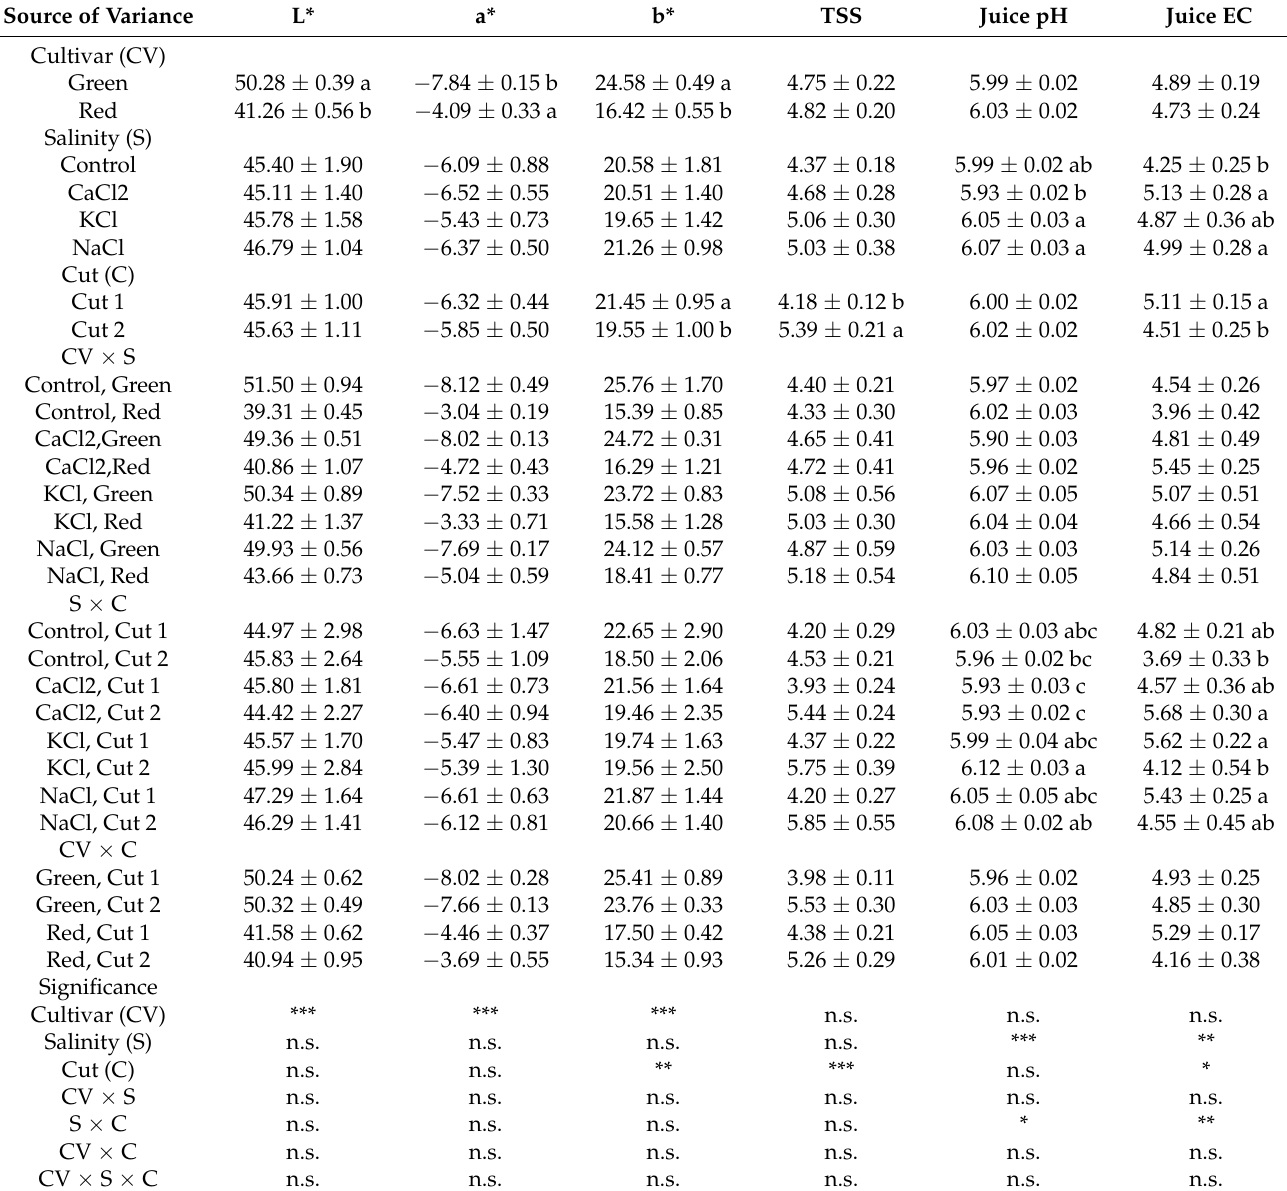
Table 2. Significance of the main factors (cultivar, salinity, and cut order) and their interactions on leaf colorimetric attributes (L*, a*, and b*), total soluble solids (TSS; ◦ Brix) content, juice pH, and juice electrical conductivity (EC; dSm − 1 ) of Lactuca sativa L. var. acephala grown in a floating